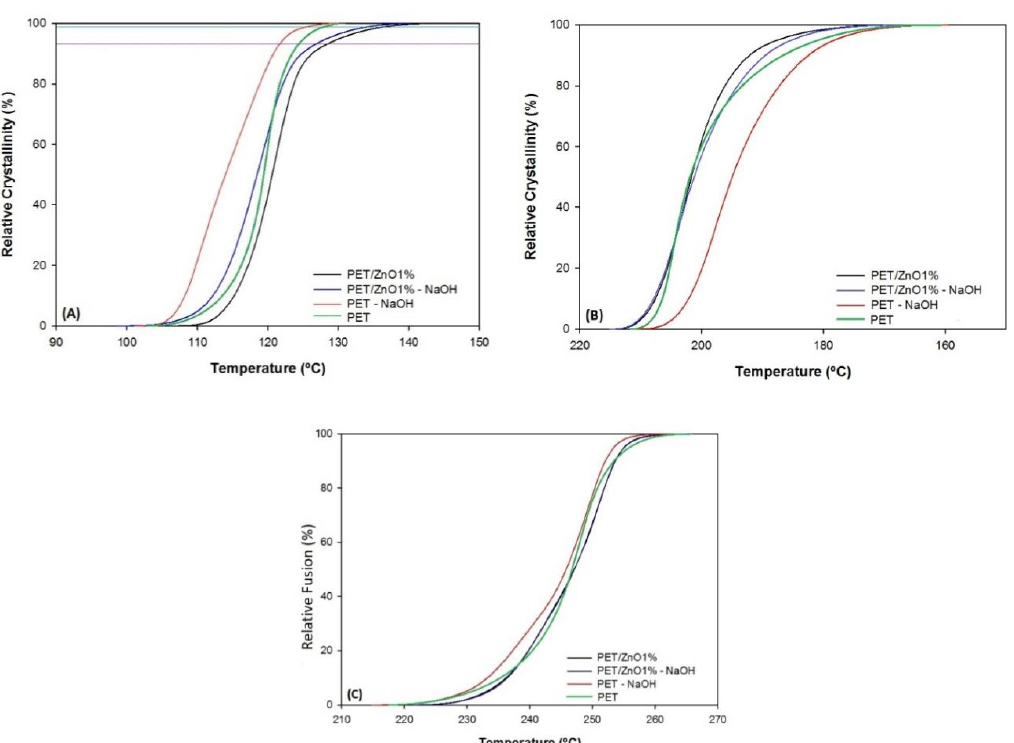
Figure 4. “S” plots. ( a ) Relative Cold Crystallinity. ( b ) Relative Melt Crystallinity. ( c ) Relative Fusion. Compounds indicated. Heating/Cooling/Reheating rate of 10°/min.